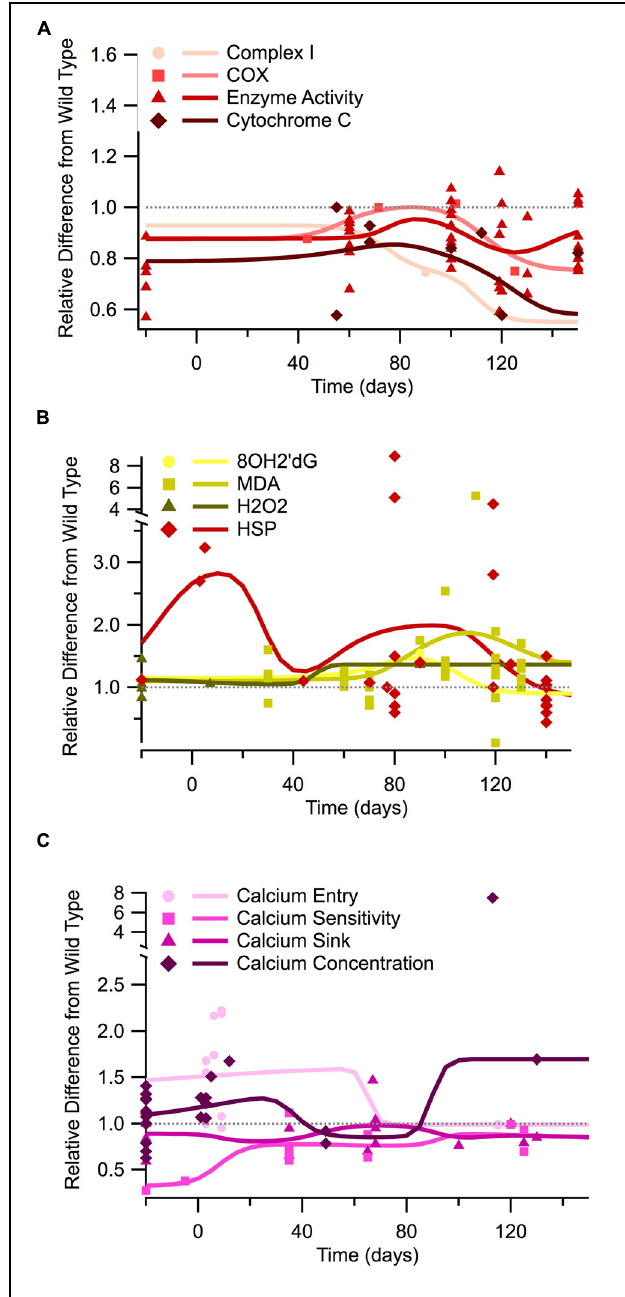
FIGURE 2 | Temporal trends of mitochondrial mechanisms, oxidant regulation, and calcium regulation in the SOD1 G93A transgenic mouse model. The ratio of SOD1 G93A to wild type (SOD1 G93A/wild type) is plotted over time for each experimental measure. For visualization purposes, in vitro data is plotted at − 20 days, embryonic data is plotted at − 5 days, and in vivo time points are plotted at their corresponding post-natal day of assessment, 0–150 days. A gray dotted line is provided to show the expected wild type or homeostatic value. Trend lines are generated based on a Gaussian average of the normalized data points. (A) Mitochondrial mechanisms (Complex I, COX, enzyme activity, and cytochrome c). (B) Oxidant markers (8OH2 (cid:2) dG, MDA, H 2 O 2 ) and protective heat shock proteins (HSPs). (C) Calcium regulation (entry, sensitivity, sink, and cytosolic